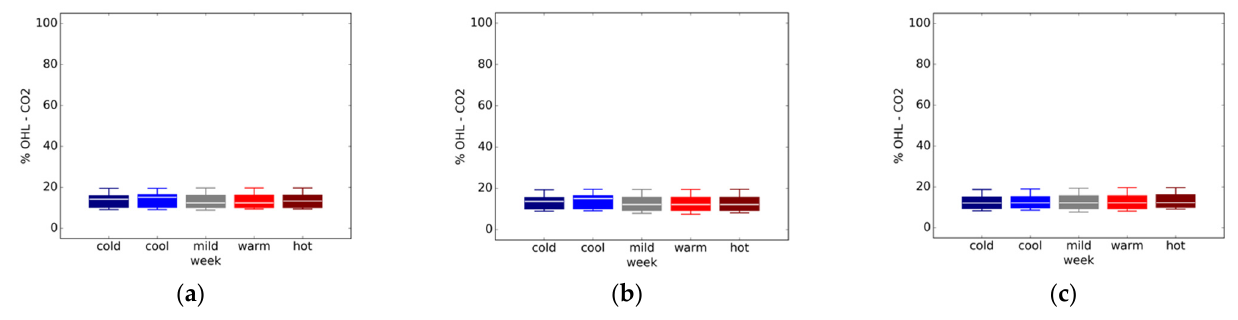
Figure 4. Ventilation OHL for Houston ( a ), San Francisco ( b ), Chicago ( c ).